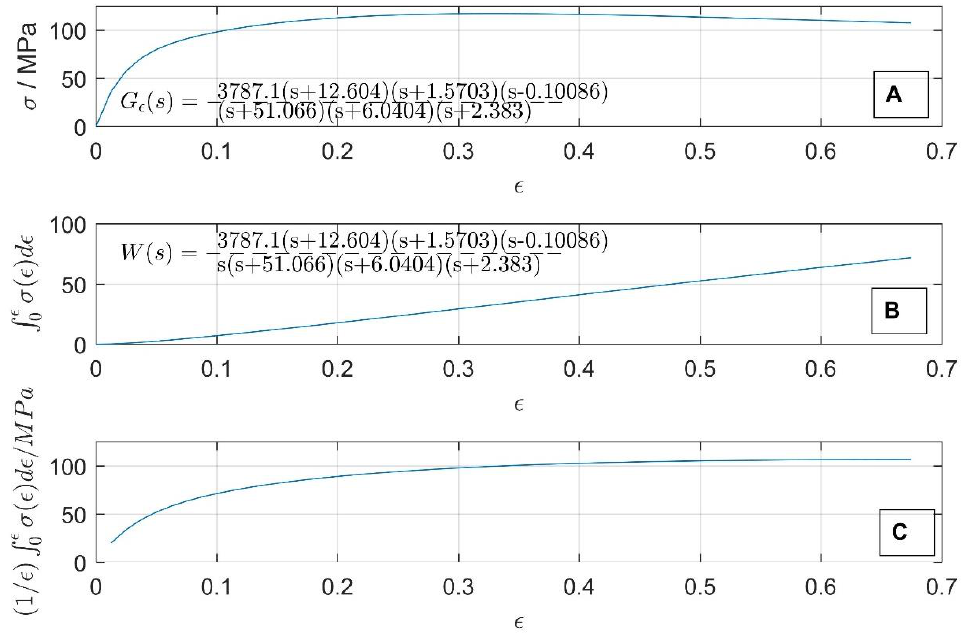
Figure 2. True stress vs. true strain curve 𝐺 𝜀 (𝜀) ( A ) for 1000 °C and a strain rate 0.01 s −1 , work done per unit deformation ( B ) and calculated average flow stress 𝜎 𝐹𝑀 ( C ).